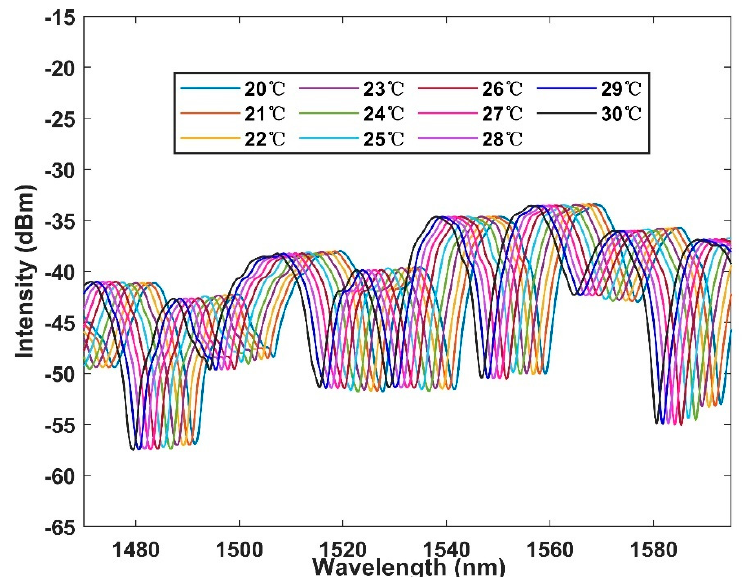
Figure 5. Output spectrum of temperature response with broadband light source (BBS) in the range of 20 °C–30 °C within 1 °C per interval.